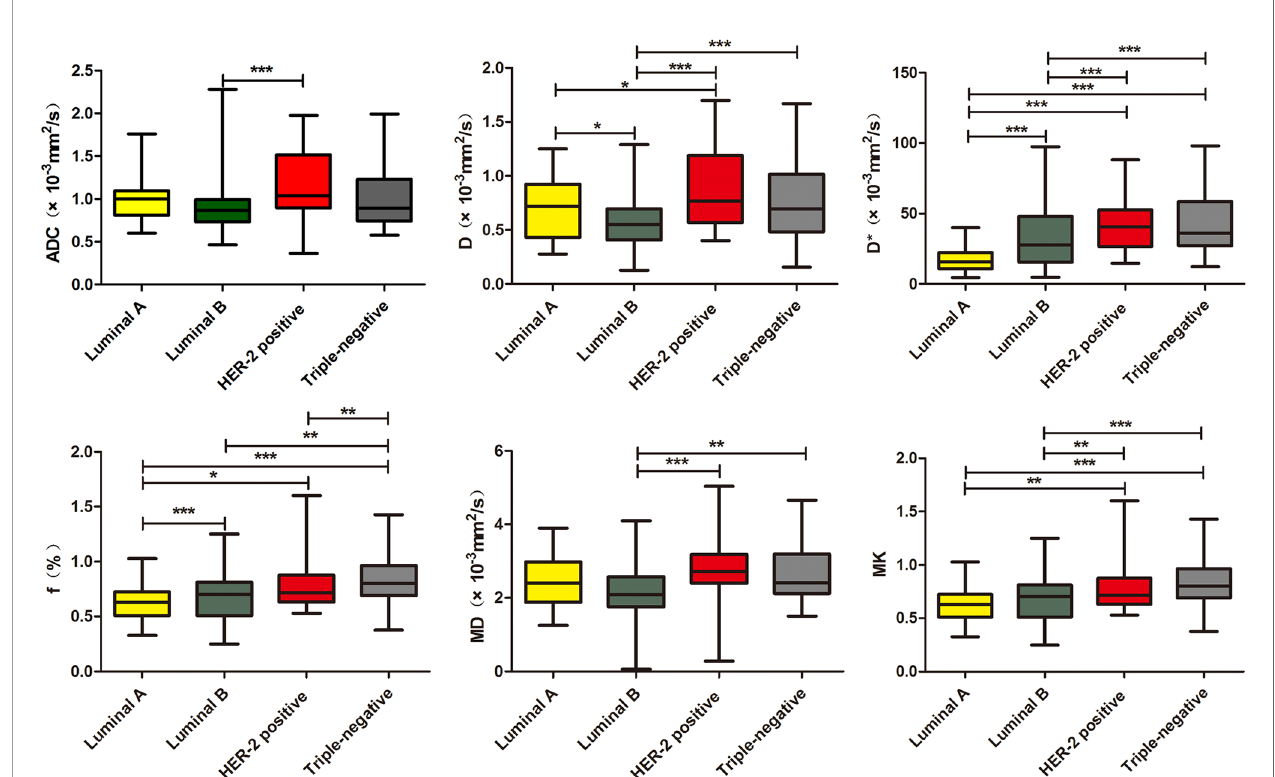
FIGURE 4 | Boxplots of ADC, D, D*, f, MD, and MK in differentiating genotypes of breast cancer. *p < 0.05, **p < 0.01, ***p < 0.001.